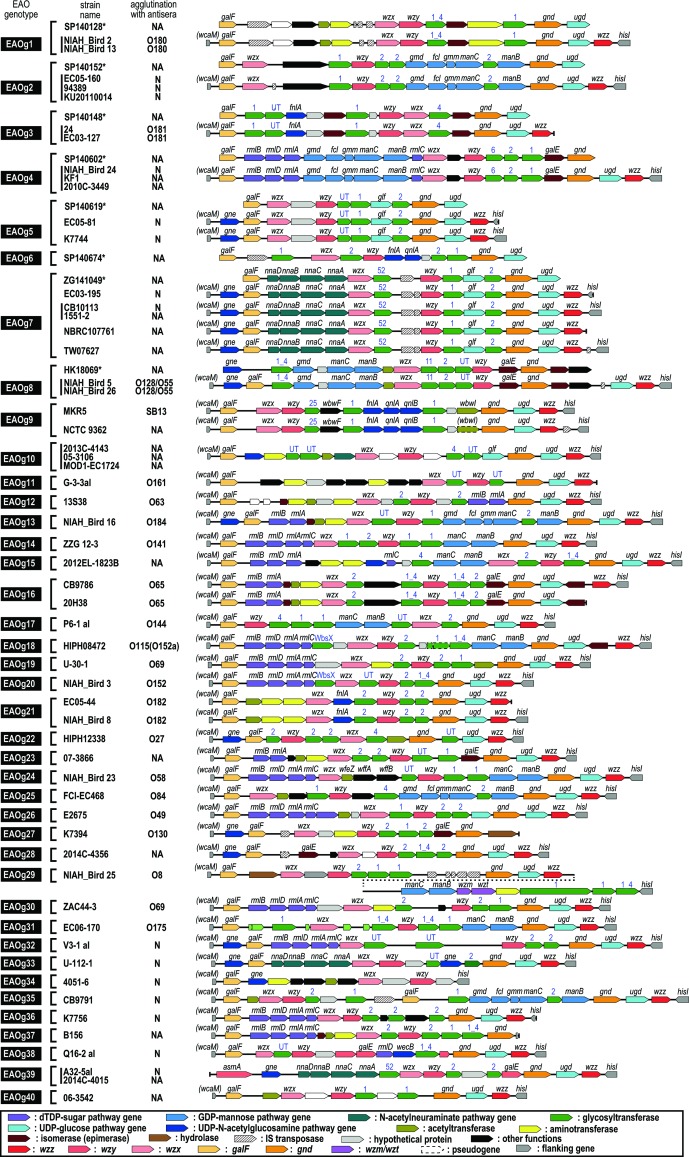
Genetic structures of the 40
E. albertii
 O-genotypes identified. Genotypes, strain names and results of the agglutination test using antisera against known
E. coli
/
Shigella
 O-serotypes (N, no agglutination; NA, not applicable) are indicated on the left side. The structures of O-AGCs were deduced from the genome sequences of each strain except for the eight strains indicated by asterisks. Only the sequences of O-AGCs are available for the eight strains. For putative glycosyltransferases (indicated by green), types of domain families are indicated instead of gene names (UT, untypable).